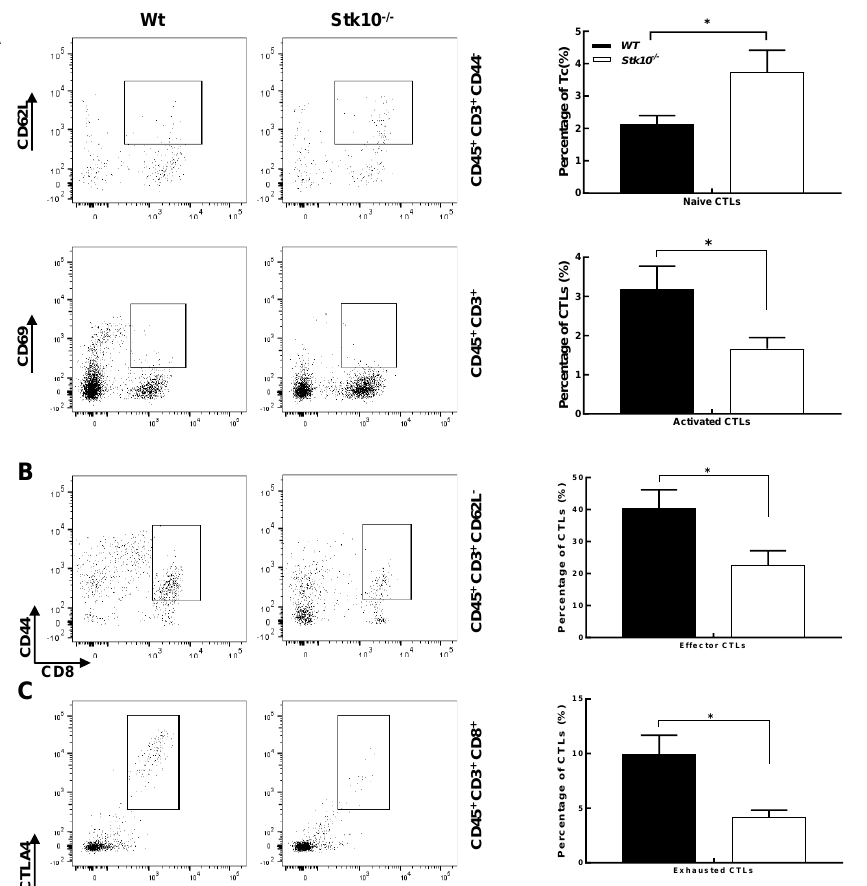
Figure 6. Stk10 deletion led to a significant impairment in the activation of CD8 + T cells. ( A ) Naïve CTLs (CD45 + CD3 + CD8 + CD44 – CD62L + ). ( B ) Activated CTLs (CD45 + CD3 + CD8 + CD69 + ), effector CTLs (CD45 + CD3 + CD8 + CD44 + CD62L - ). ( C ) Exhausted CTLs (CD45 + CD3 + CD8 + PD-1 + LAG3 + ). The frequencies (%) of CTLs at different stages in TILs cells are presented in the bar graphs as mean ± SEM. p values were determined by unpaired two-tailed t -tests. * p < 0.05. n = 5/group.